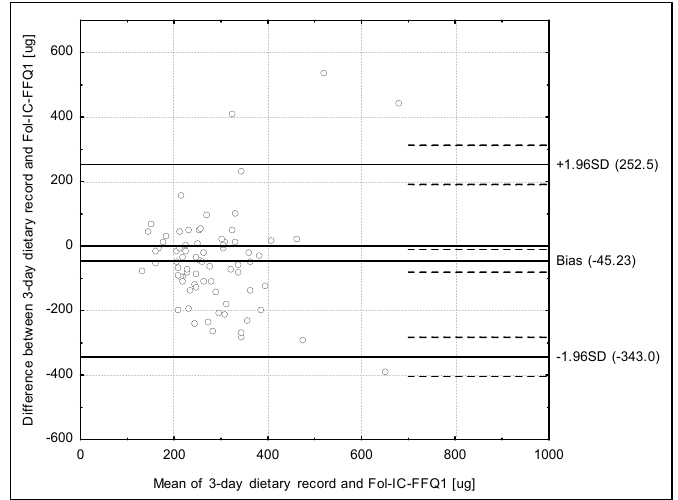
Figure 2. Bland ‐ Altman plot comparing Fol ‐ IC ‐ FFQ1 with 3 ‐ day dietary record folate daily intake